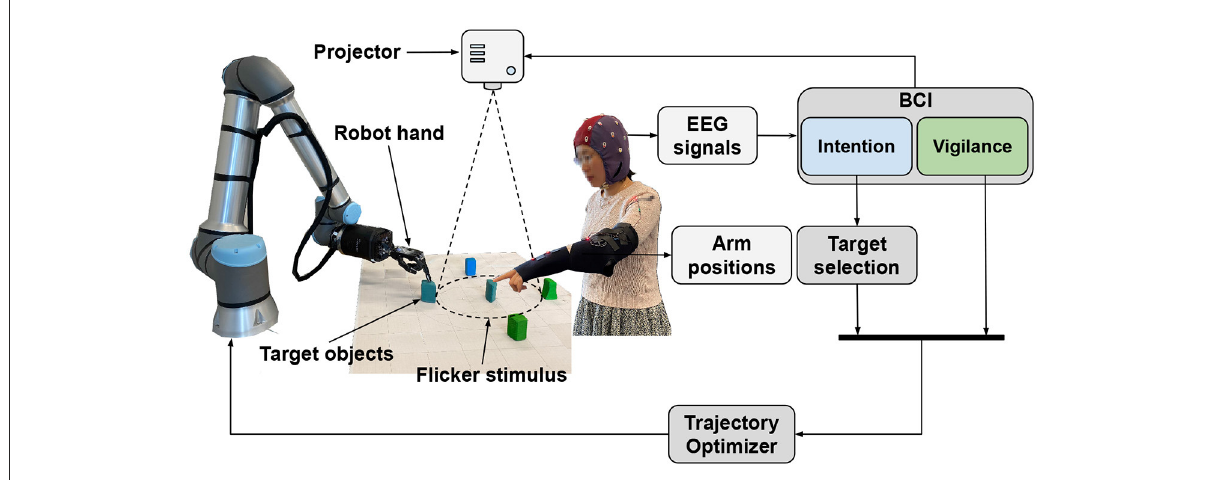
FIGURE1 The proposed HRC